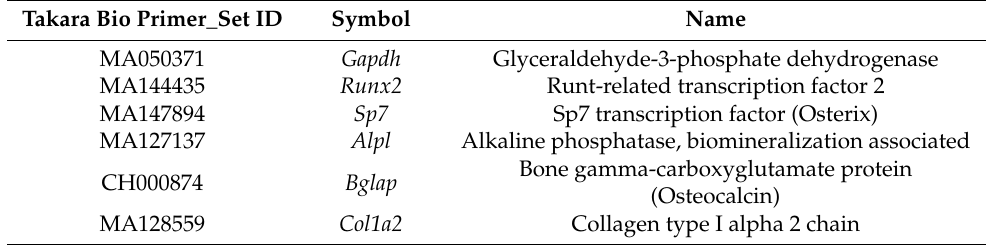
Table 1. Osteoblast markers assessed by real time